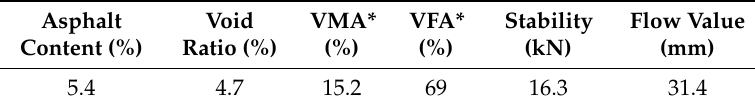
Table 2. Marshall test results of SBS modified